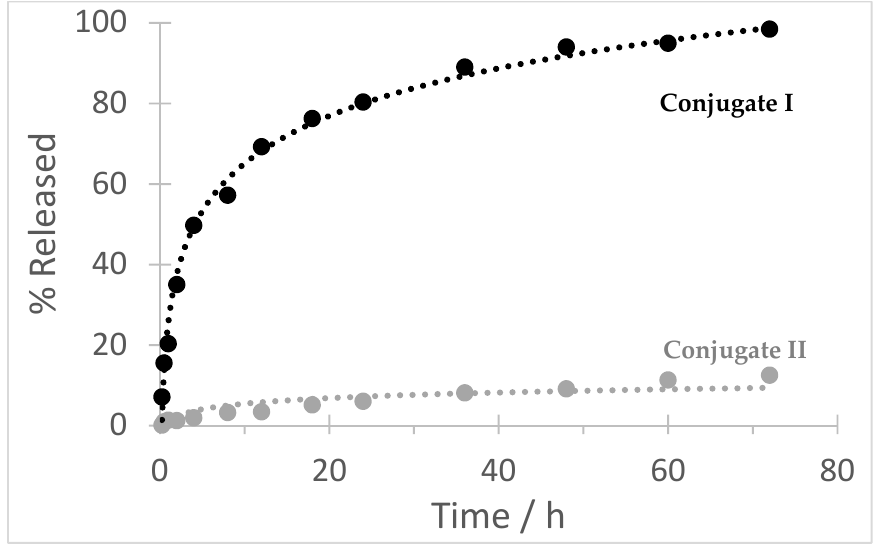
Figure 7. Stability of conjugates I and II in a buffer pH 7.4.